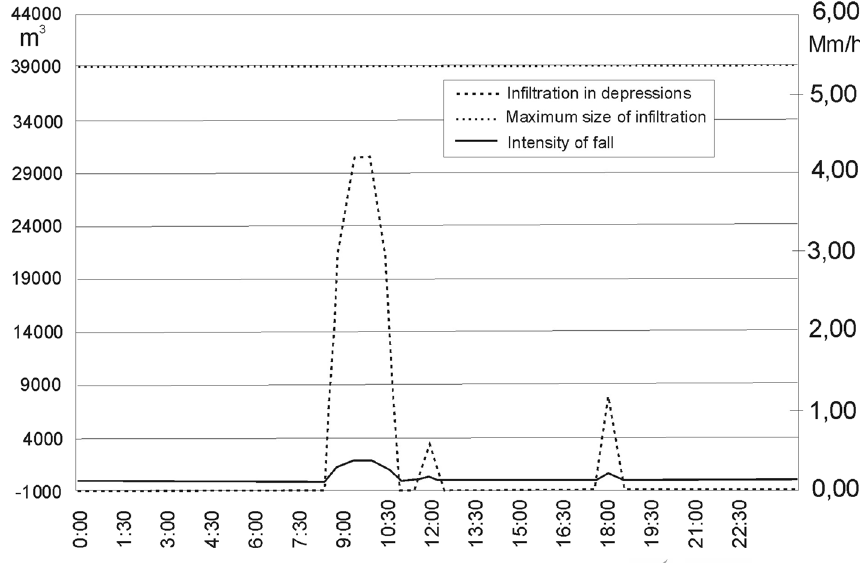
Fig. 14 Infiltration com- pared with precipitation on 18.02.2001(Major and Cieśliński